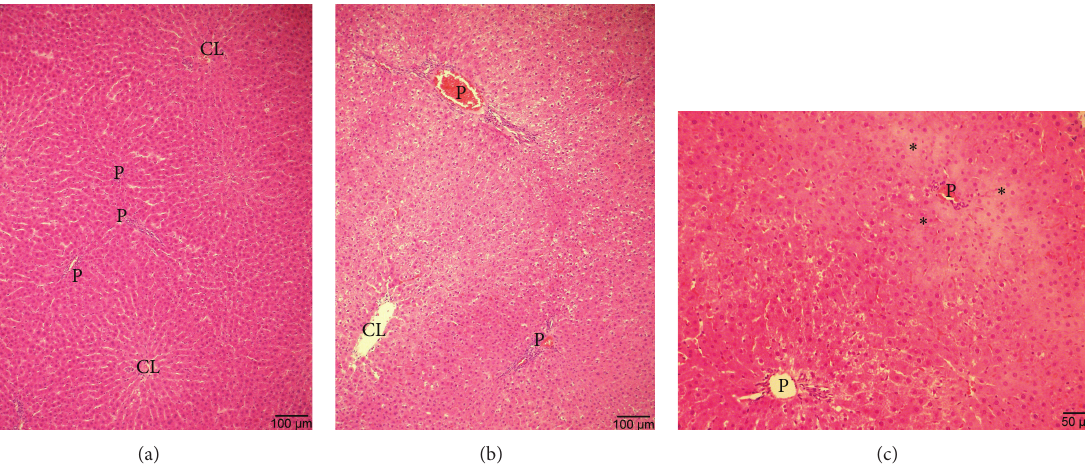
Figure 3: Representative light micrographs of the left liver lobe of sham-operated rats (a) and of the left lobe of rats submitted to ischemia/reperfusion (I/R) (b and c). Hematoxylin and eosin staining. The sham animal shows normal hepatocyte and sinusoid morphology (a). In animals submitted to I/R the lower magnification picture (b) shows decreased eosinophilia of hepatocytes, hepatocyte vacuolation, disarrangement of hepatocyte cords, and altered sinusoidal dilatation (b). An area of extensive hepatocyte necrosis and plate disintegration (black stars) is shown under higher magnification in (c), example of grade 3. P: portal vein; CL: centrolobular vein.